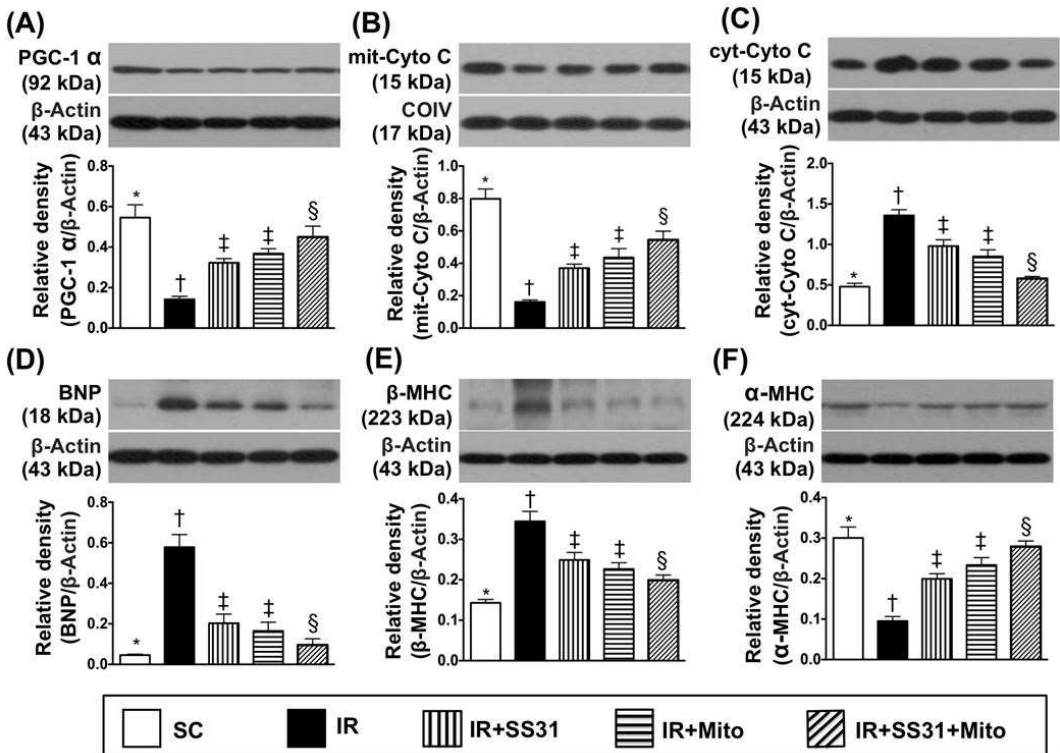
Figure 8. Energy integrity and pressure/volume overload biomarkers in LV myocardium after IR procedure. ( A ) Protein expression of Peroxisome proliferator-activated receptor gamma coactivator